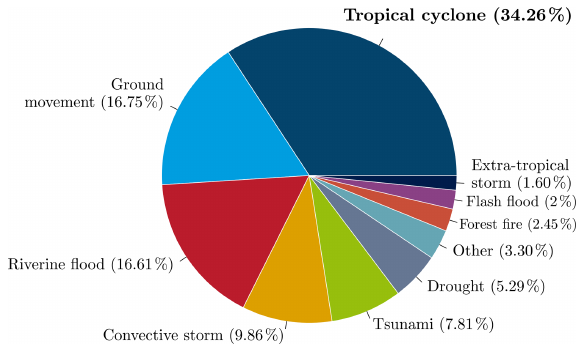
Figure 16. Proportion of damage cost (total damage in USD) by disaster subtypes reported in EM-DAT. Using the number of people affected places tropical cyclones after riverine floods and droughts, and the number of deaths places ground movements in the first po- sition (see Table A1 for details).